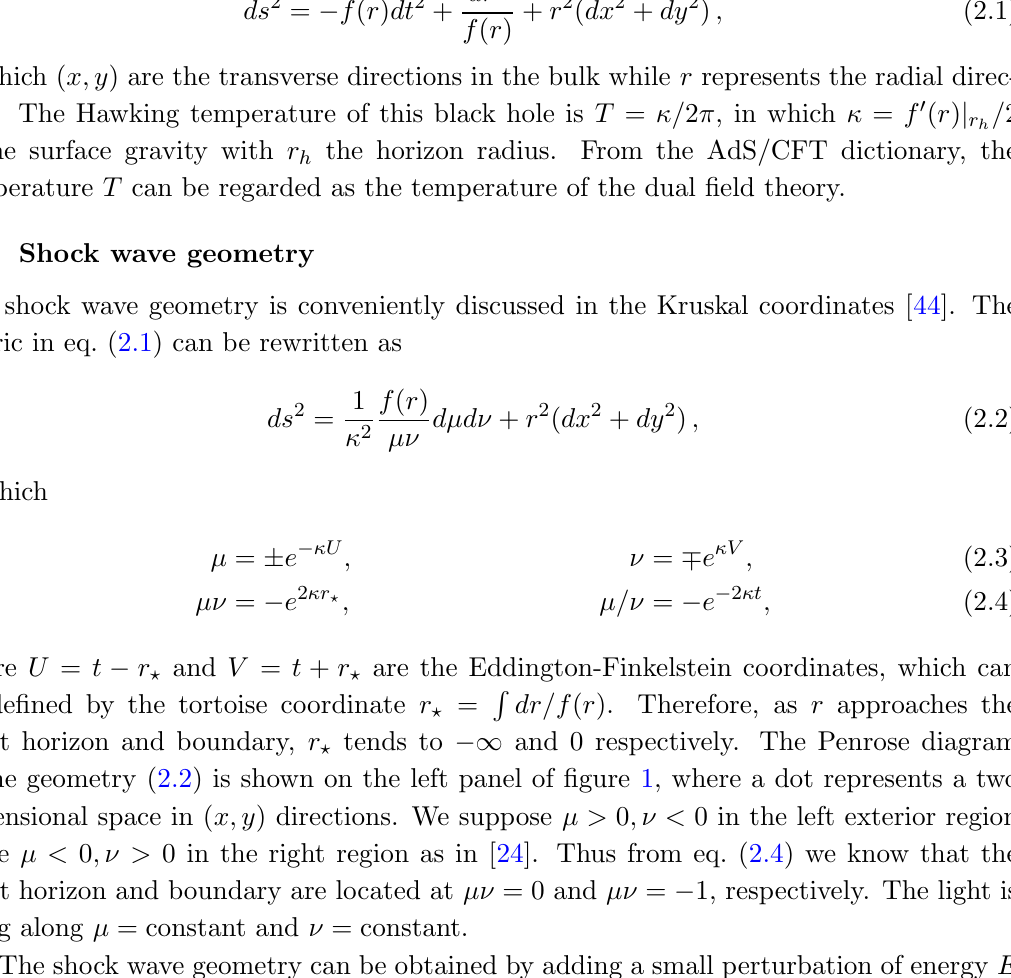
Figure 1 . Penrose diagrams for an eternal black hole without (left panel) and with (right panel) a perturbation. h is the shift on the horizon between the left and right Kruskal coordinate (cid:23) . line